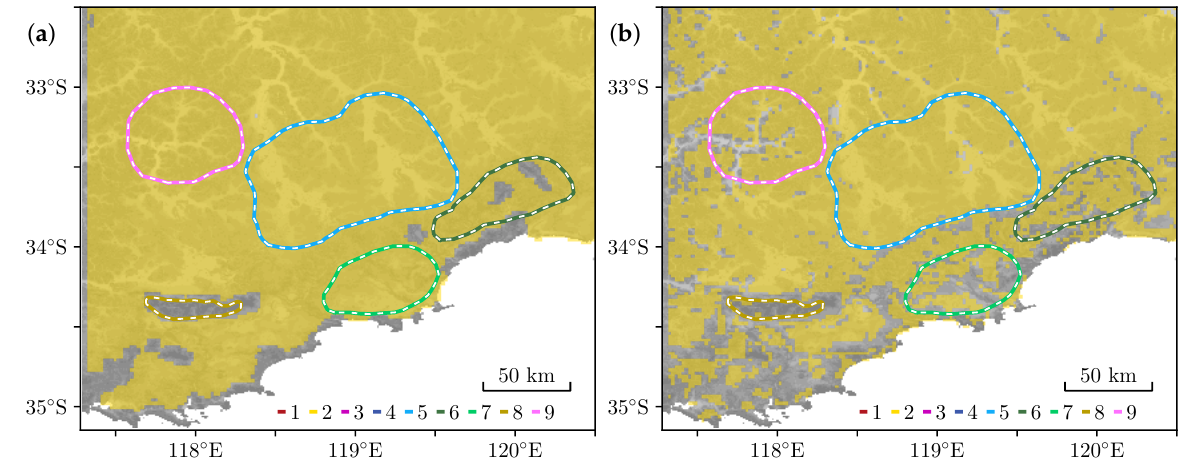
Figure 9. Novelty detection, zoom of the SW of our model region. ( a ) IsolationForest, s = 8.7km. The detected region matches the Stirling Range as marked by a human domain expert. LocalOutlierFactor ( b ) produces many false